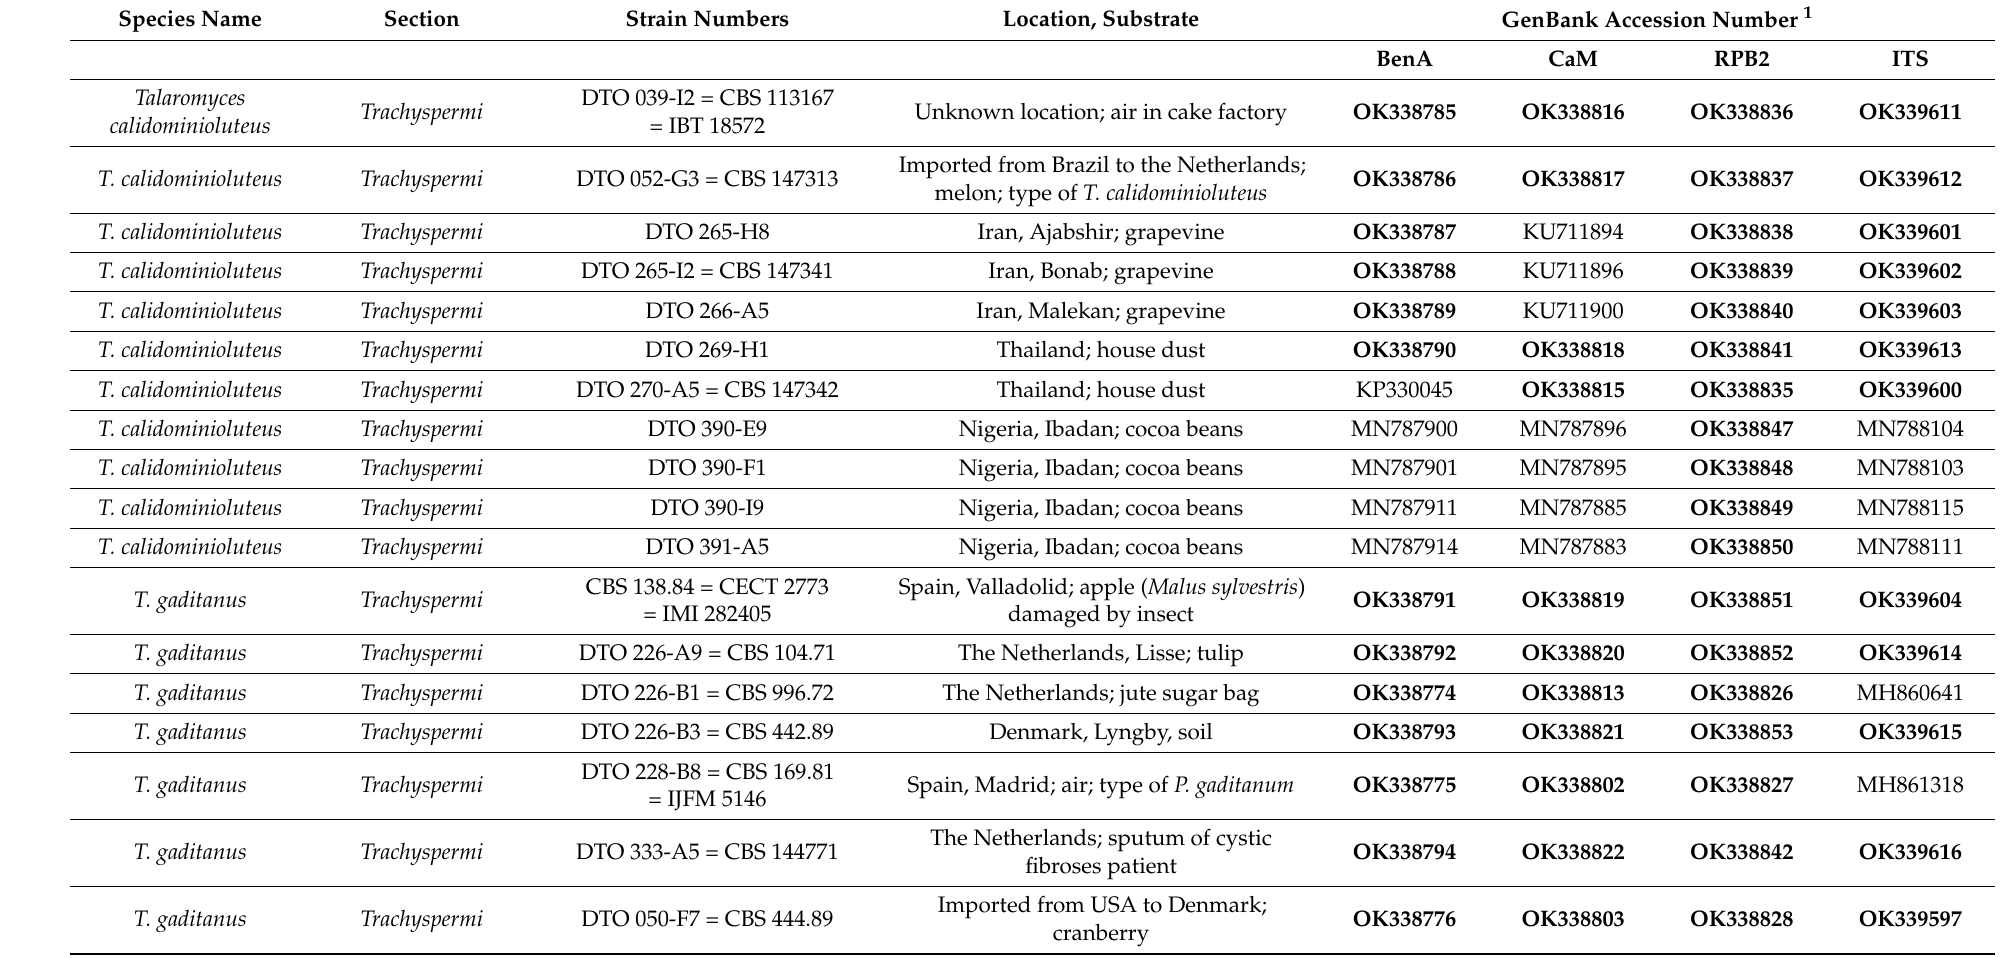
Table 1. Overview of strains used in